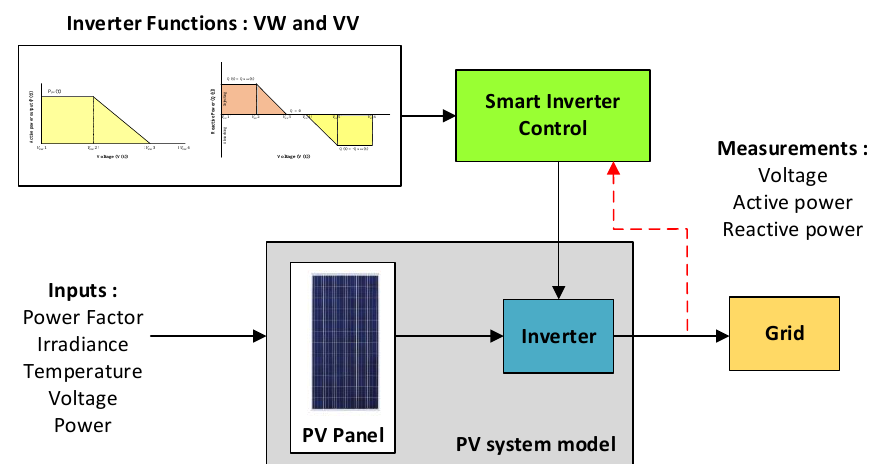
Figure 6. Block diagram of the OpenDSS PV system model with inverter controls.